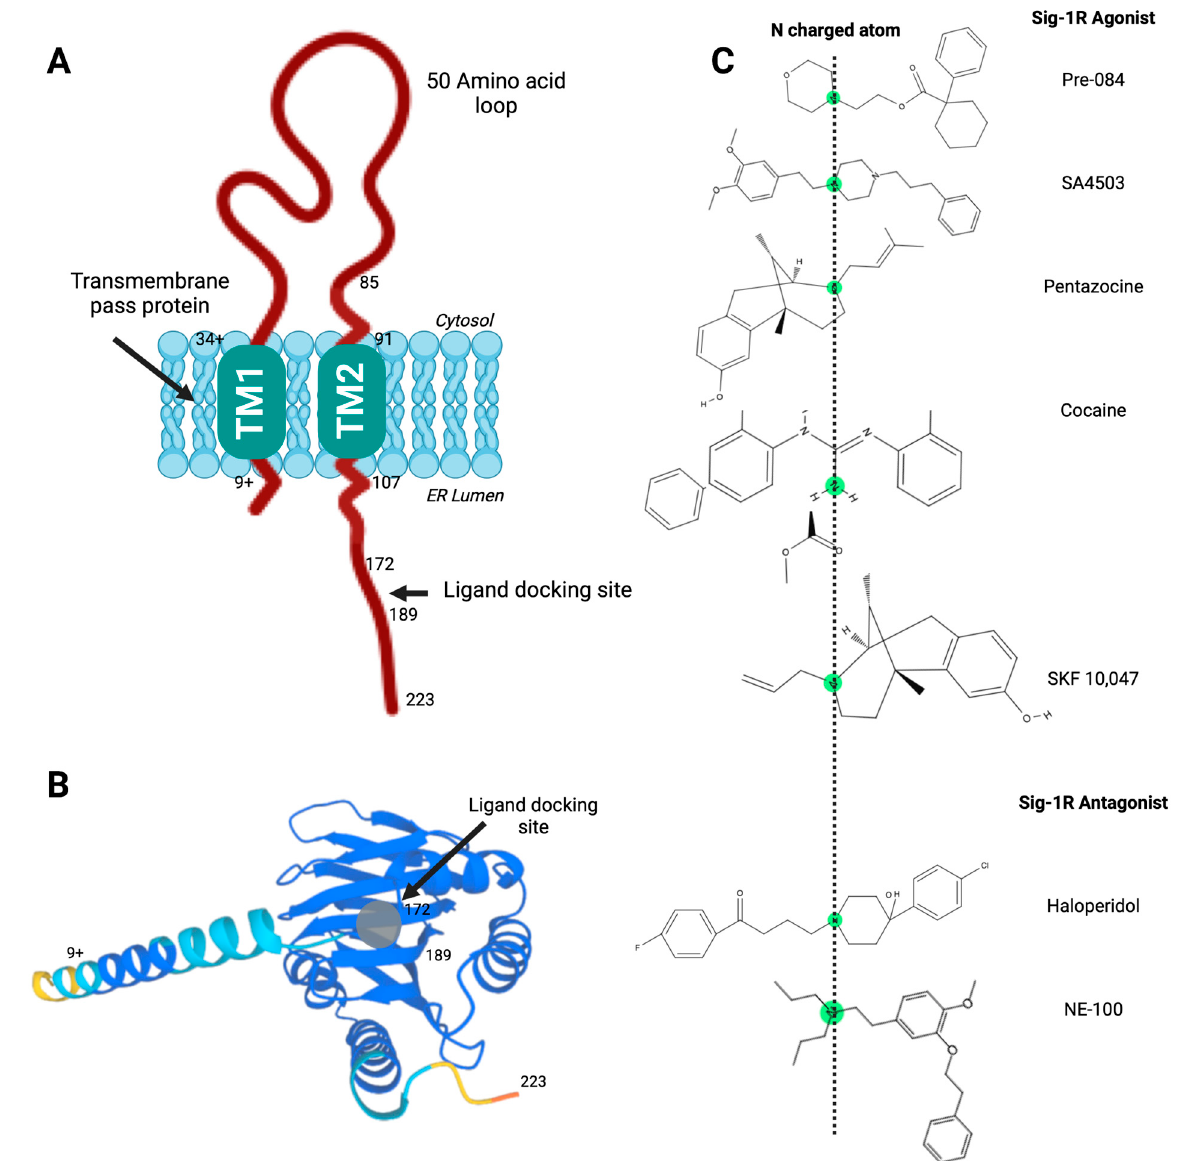
Figure 1. Sig-1R structure and ligand-receptor interactions. ( A ) Proposed model of Sig-1R with two transmembrane helices and a C-terminal ligand docking site; ( B ) Sig-1R tertiary structure with a ligand docking site predicted to accommodate agonist and antagonist ligands; ( C ) High-affinity ligands of Sig-1R contain a nitrogen atom connected to long alkyl chains essential for the molecular coupling of such diverse compounds and their stereoisomeric forms. Pharmacophore model for the Sig-1R ligands (agonists and antagonists), in which this central basic amine nitrogen atom, surrounded by two hydrophobic features, interacts with the bulky alternate chains of ligands without altering their binding affinity.